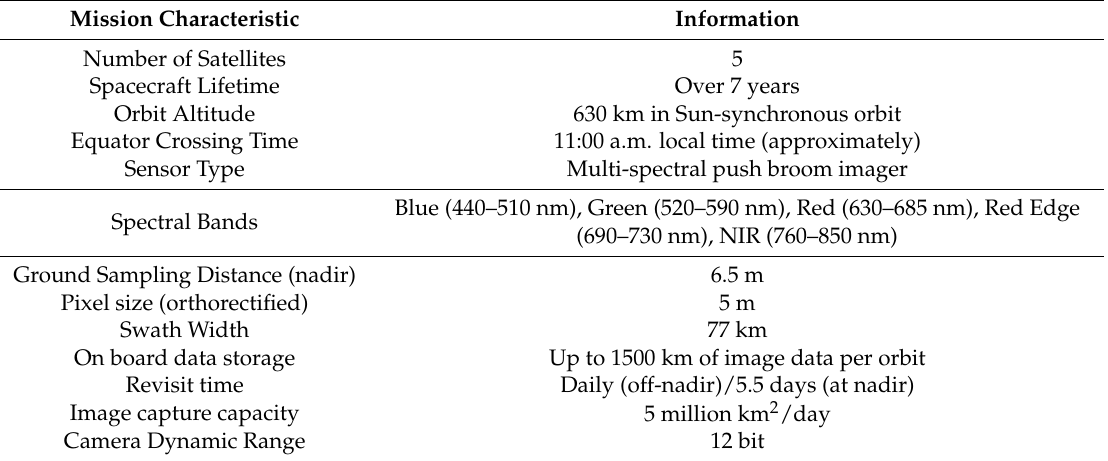
Table 3. RapidEye System technical data